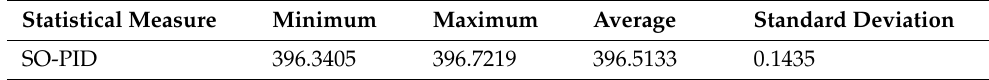
Table 1. The statistical analysis of the numerical results for SO-PID controller. Statistical Measure